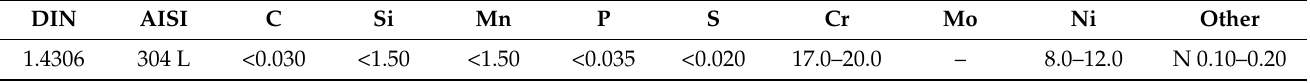
Table 1. Nominal chemical composition of the 304L